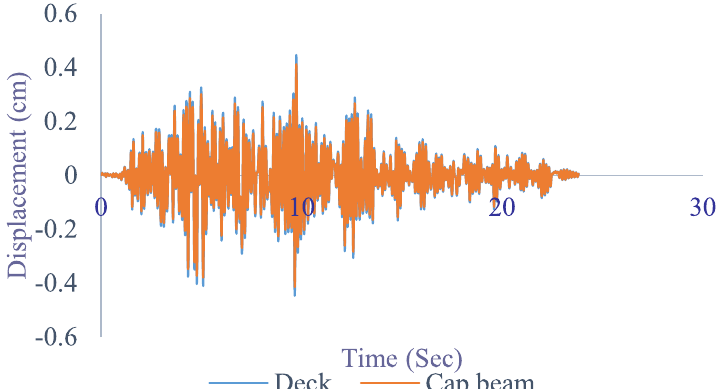
Fig. 14 The lateral displacement of points Deck and Cap beam in the transverse direction (Y) in model 1 under the Tabas earthquake